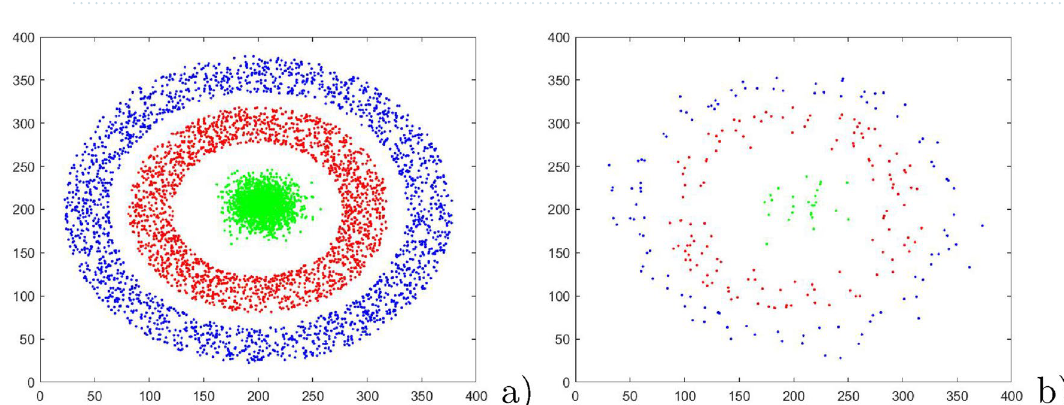
Figure 3. The reduction result of linear boundary dataset.